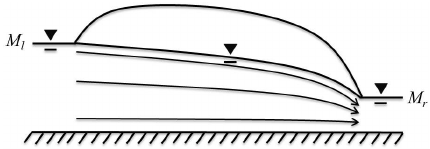
Figure 1. Schematic of a simple profile with Dirichlet boundary conditions on the right and left (M r ,M l ) and steady-state, variably saturated flow. In the theory, the vertical and horizontal extents of the cross section are assumed to be